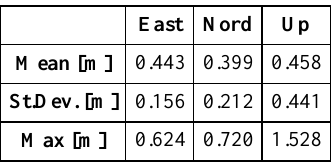
Table 3. Statistics of residuals on GCPs for RGB survey on maize.